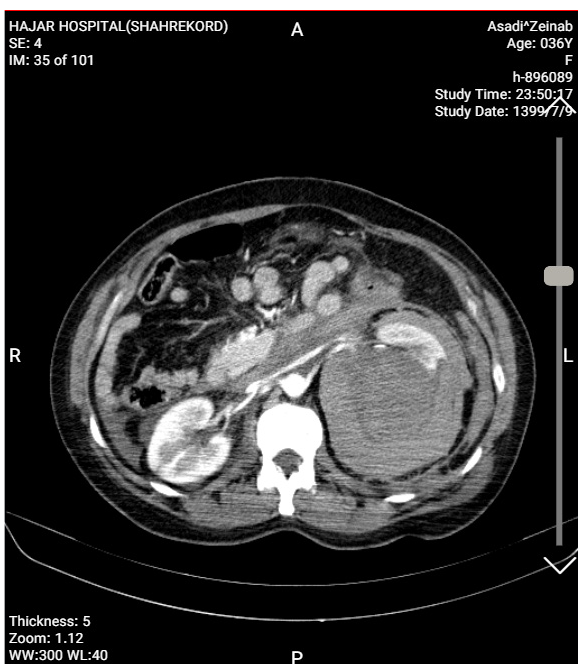
Figure 1. CT scan indicating the anterosuperior displacement of the left kidney. Note . CT: Computerized tomography.